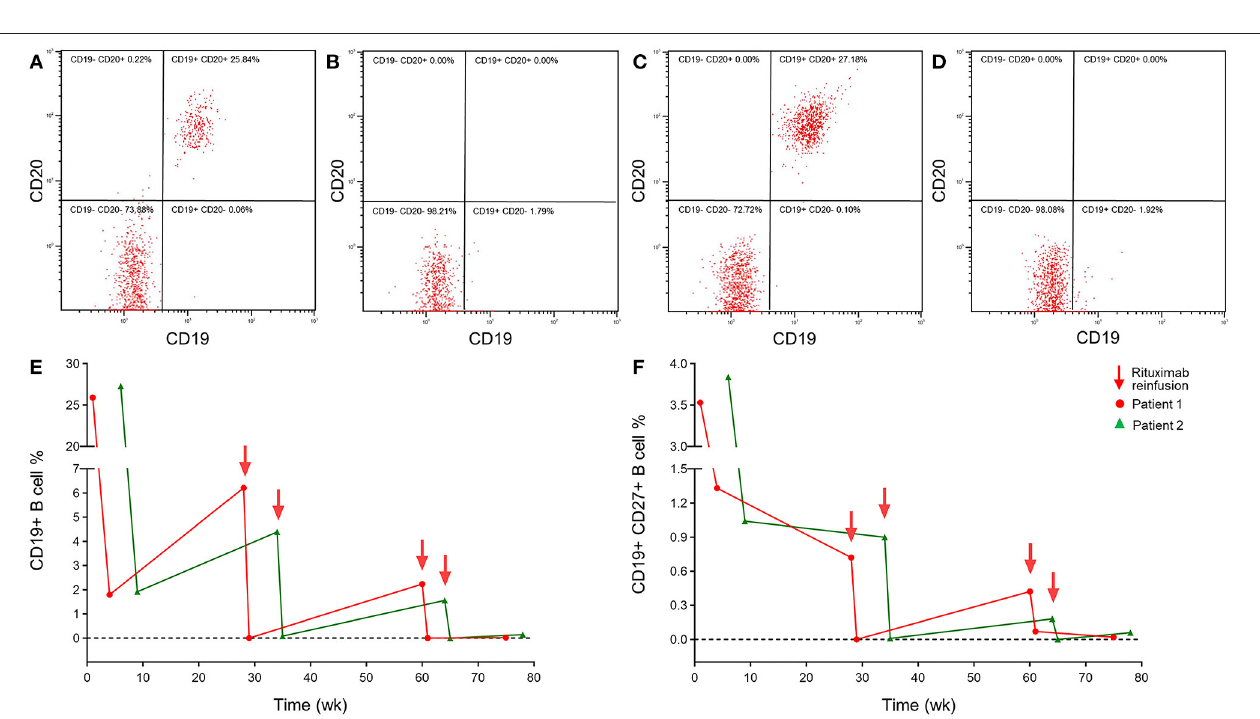
FIGURE 2 | A peripheral blood flow cytometry immunophenotype showed depletion of CD20 + B lymphocytes in NBD patients with reduced-dosage rituximab treatment 100mg IV once per week for 3 consecutive weeks. Peripheral blood flow cytometry immunophenotype in patient 1 before (A) and after (B) 3 weeks treatment, patient 2 before (C) , and after (D) 6 weeks treatment. (E) The repopulation of CD19 + B lymphocytes in patients with NBD during rituximab therapy still remains at a lower level. (F) The lower repopulation of CD19 + CD27 + B lymphocytes paralleled that of CD19 + B cells after rituximab treatment.